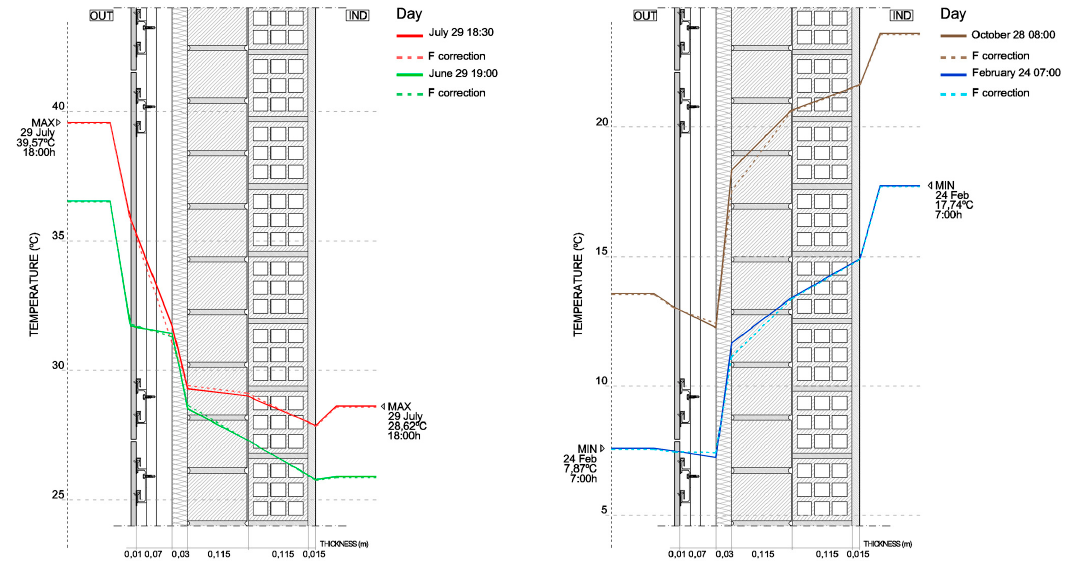
Figure 20. Comparison of temperature gradients before and after applying the f c .